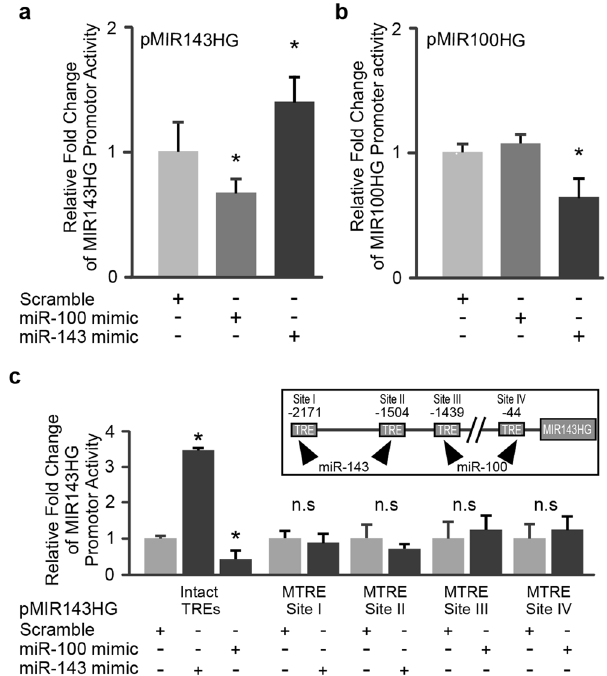
Figure 4. Differential promoter activities of MIR143HG and MIR100HG in the presence of exogenous miR- 100 or miR-143 in HCMa cells. ( a ) Promoter activities of MIR143HG were enhanced and inhibited in the presence of exogenous miR-143 and miR-100 respectively. ( b ) Promoter activity of MIR100HG was attenuated in the presence of miR-143 mimics. ( c ) Mutagenesis analyses of MIR143HG promoter showing that miR-143 and miR-100 failed to interact with promoter constructs containing the mutated transcriptional response elements (MTRE) representing the respective microRNA binding sites. Inset in ( c ) depicts the relative locations of the TREs tested in this study. Data are presented as mean ± SD, n = 3, Student’s t test, * p < 0.05. n.s, non- significance, p > 0.05.